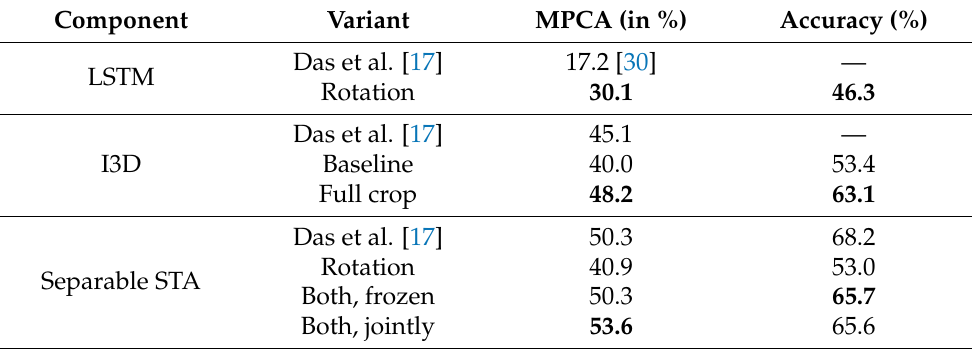
Table 2. Results for the cross-view evaluation protocol (CV 2 ). ‘Both’ refers to rotation with no distances and full crop, either ‘jointly’-trained (i.e. I3D layers as trainable) or with ‘frozen’ branches. Results in mean per-class accuracy (MPCA) and overall classification accuracy. Best result in